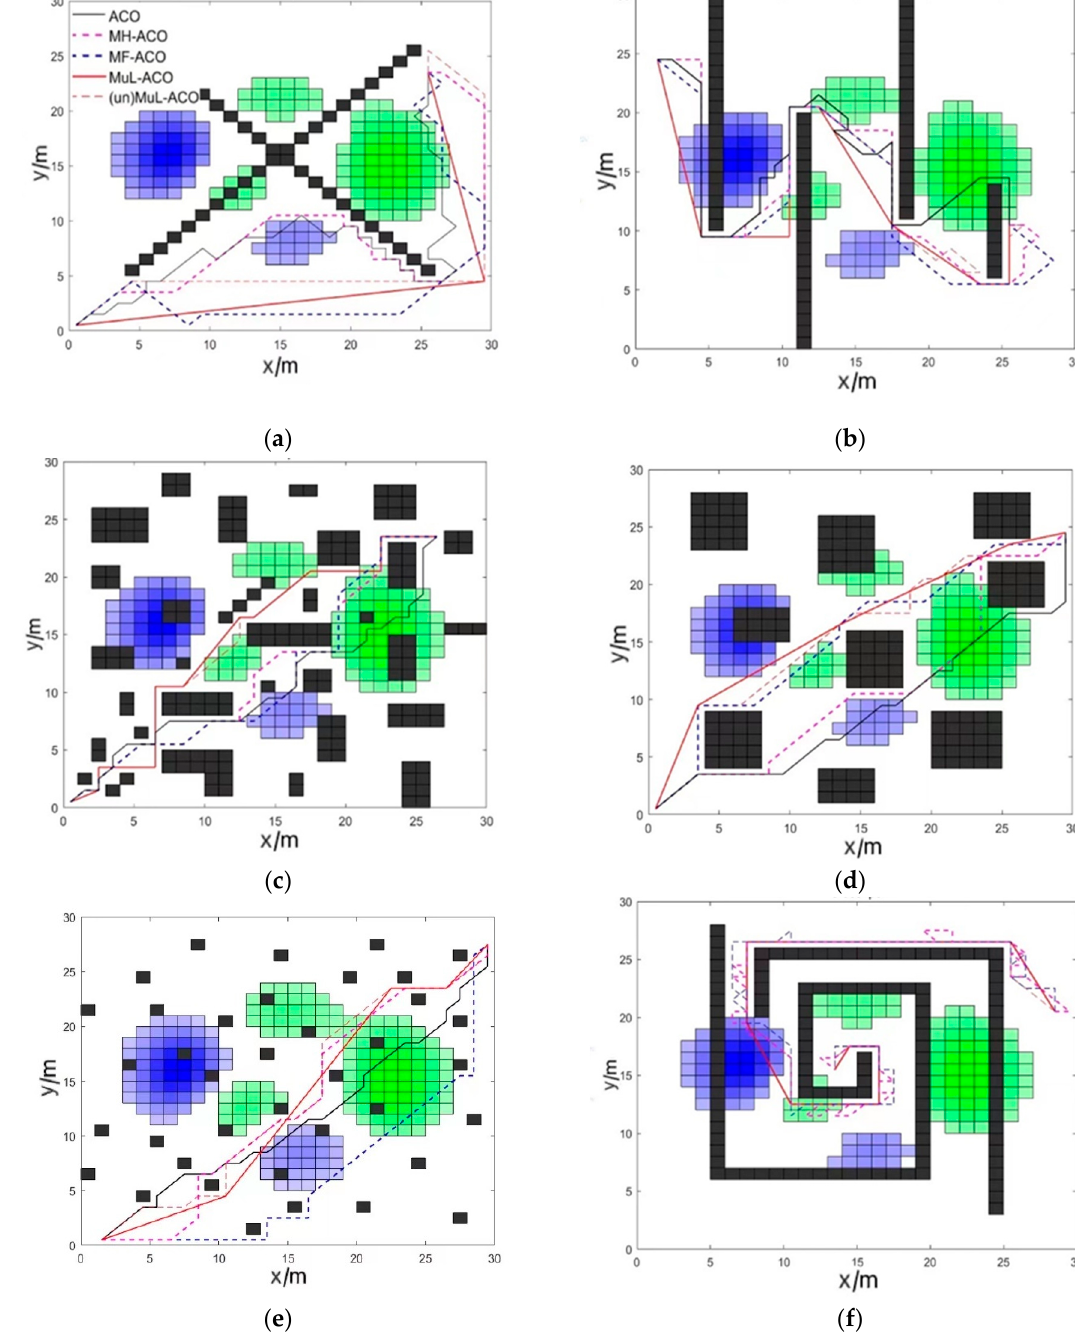
Figure 9. The trajectories generated by ACO, MH-ACO, MF-ACO, and MuL-ACO. ( a ) Map. NO.1: X-type Map; ( b ) Map. NO.2: Z-type map; ( c ) Map. NO.3: Complex1 map; ( d ) Map. NO.4: Complex2 map; ( e ) Map. NO.5: Complex3 map; ( f ) Map. NO.6: Vortex map.